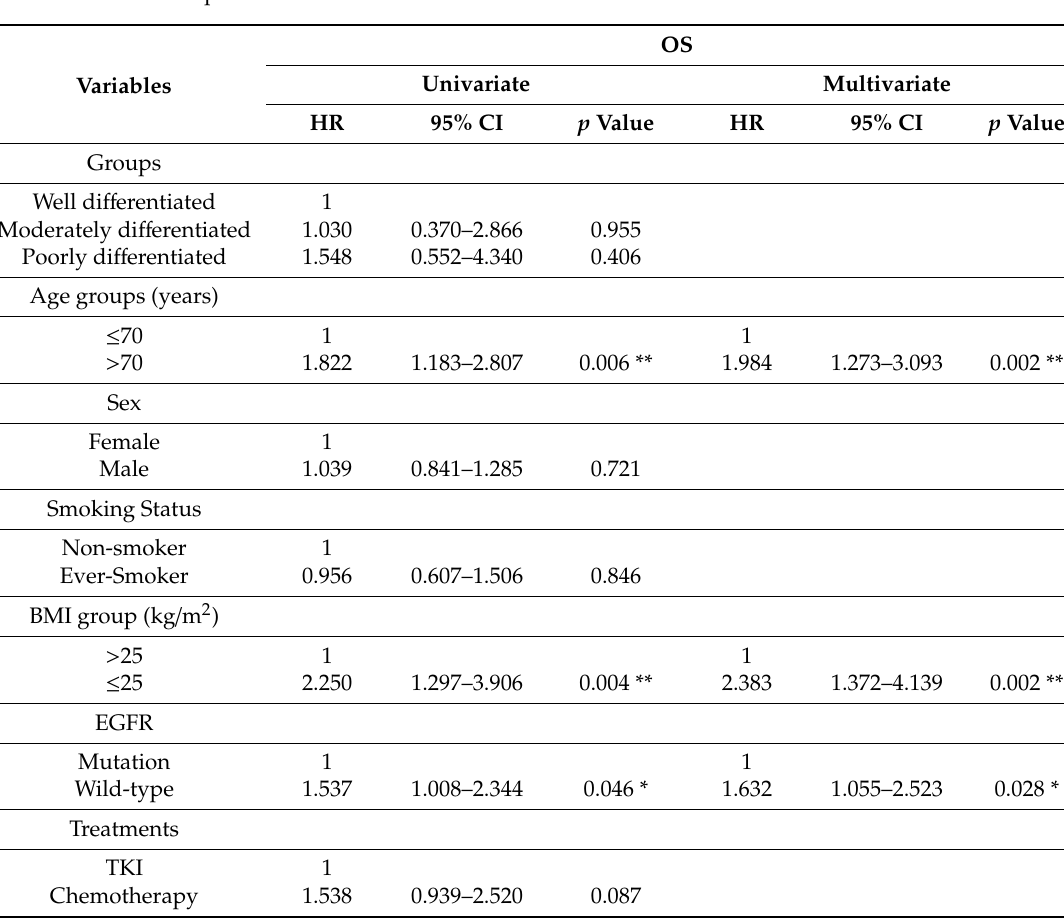
Figure 4. Kaplan–Meier survival curves for each group with wild-type EGFR and those treated with chemotherapy under new grading system: ( A ) progression-free survival; and ( B ) overall survival. Patient numbers in the respective groups are listed in Table 1. Table 3. Univariate and multivariate analyses of the overall survival in advanced lung adenocarcinoma